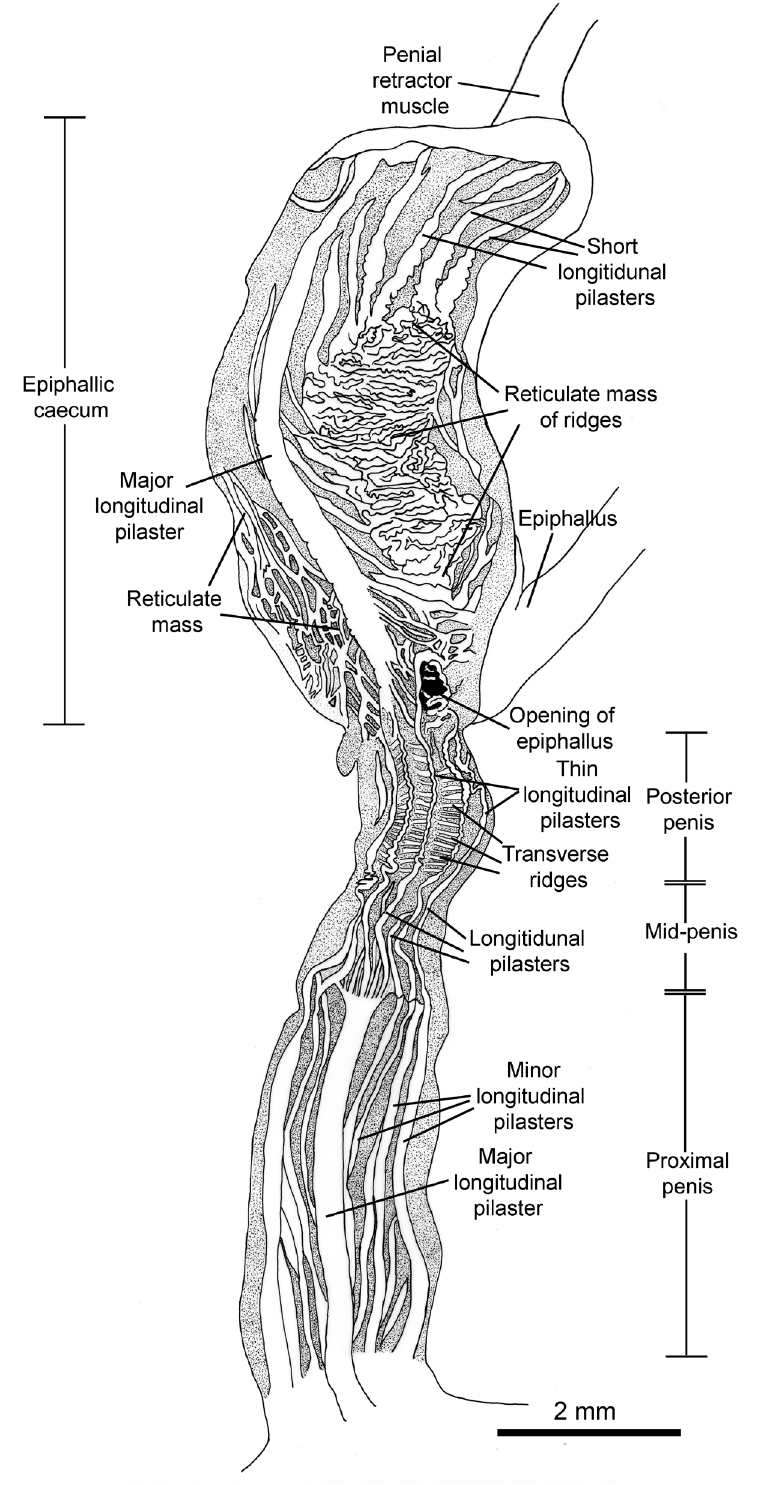
Fig. 10. Inner surface of penis in the holotype (BNHS GAS 113) of Varadia amboliensis Bhosale, Thackeray, Muley & Raheem gen. et sp. nov. Note that the short longitudinal pilasters of the epiphallic caecum are crenulated proximally. The close, fine longitudinal ridges between the longitudinal pilasters of the proximal penis are not